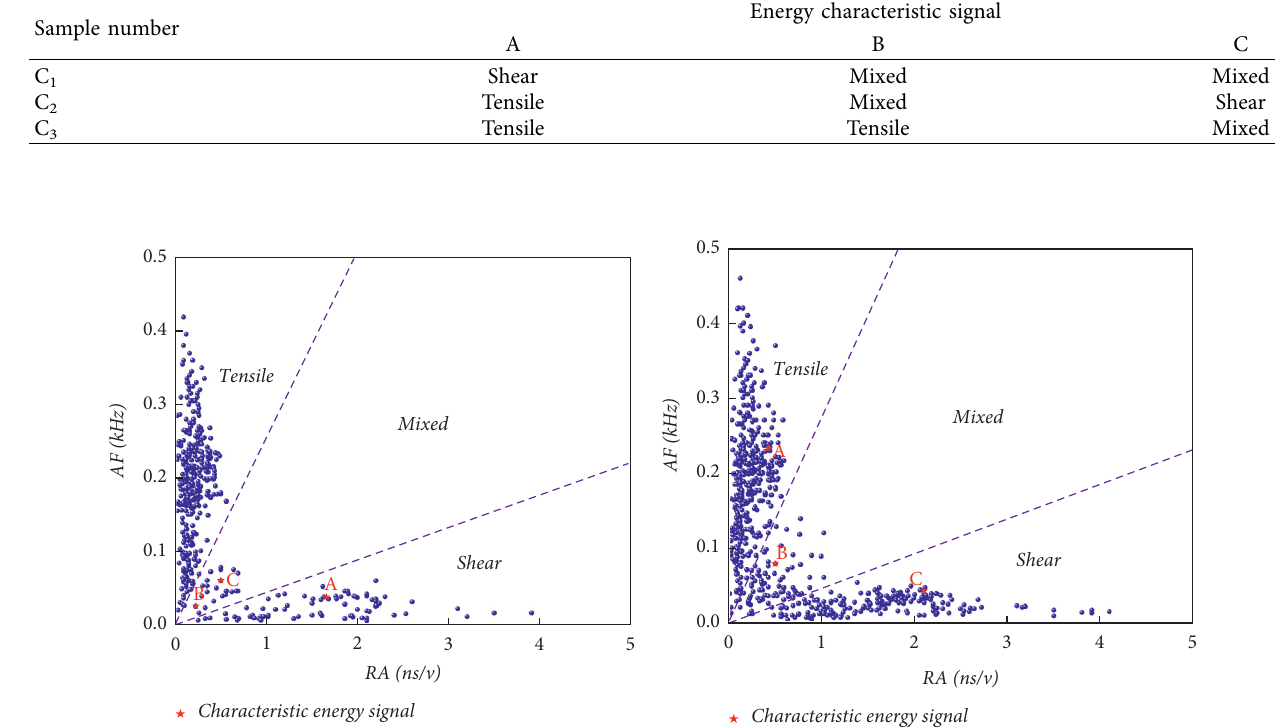
1 . (b) Sample C 2 . (c) Sample C 3